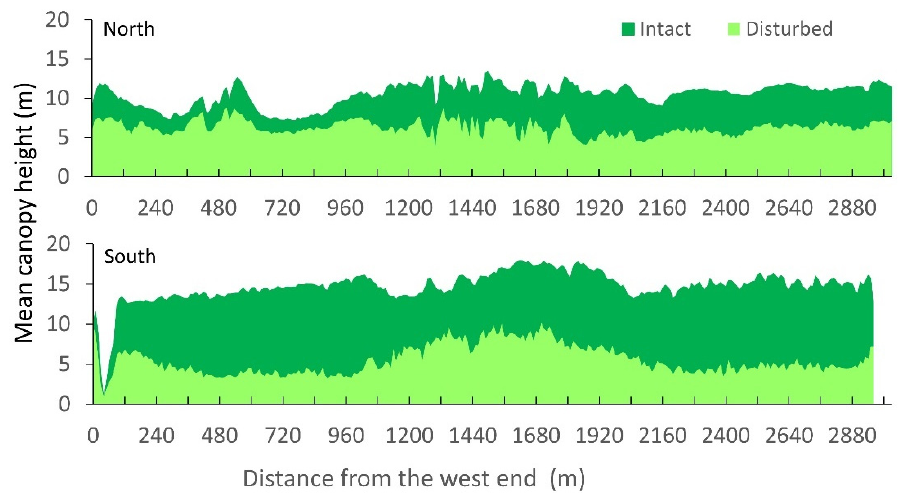
Figure 3. Mean canopy height along the north and south transects before (intact) and after (disturbed) the hurricanes in the hurricanes in September September 2017.